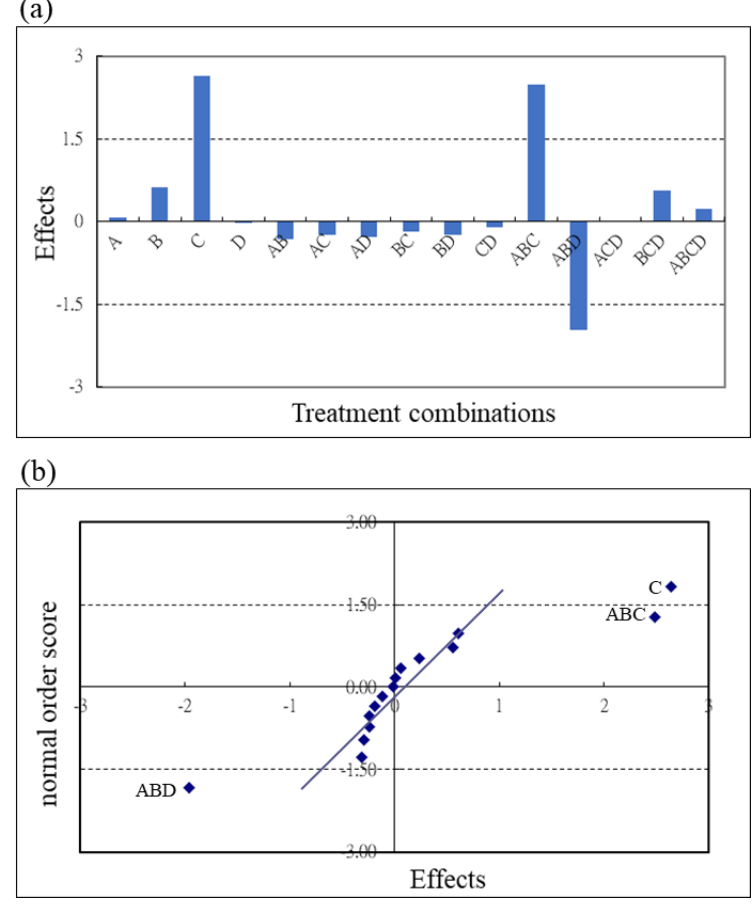
Figure 4. Results of the f irst factor screening (2 4 factorial run): ( a ) effects versus treatment combinations, and ( b ) normal plot.